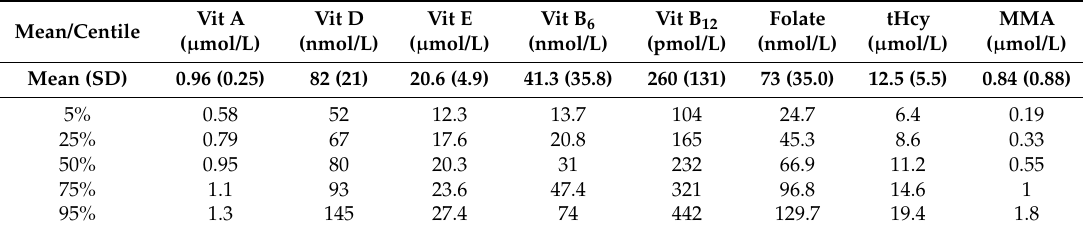
Table 3. Mean and percentile distributions of micronutrient and total homocysteine and methylmalonic concentrations among infants in Bhaktapur,